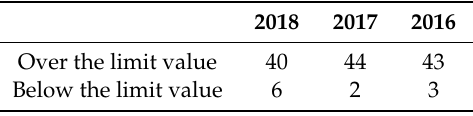
Table 4. Value added in individual